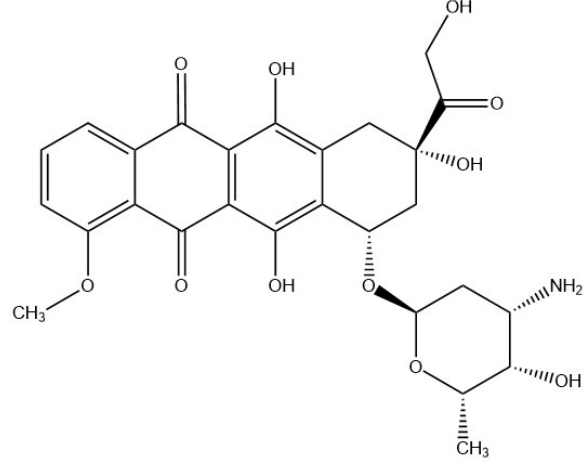
Figure 2. Structure of doxorubicin.